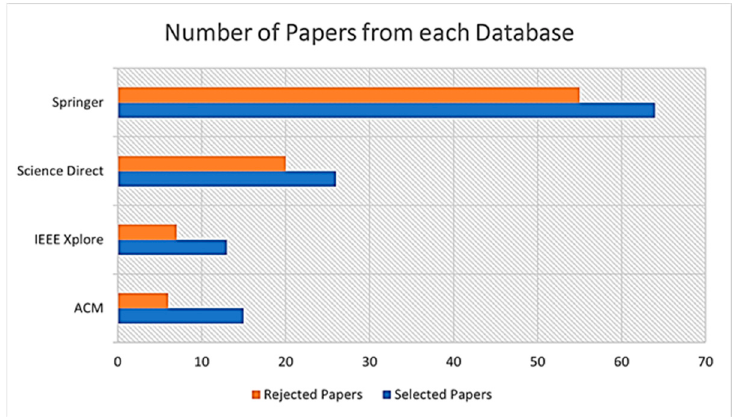
Figure 3. Distribution of papers according to the databases.